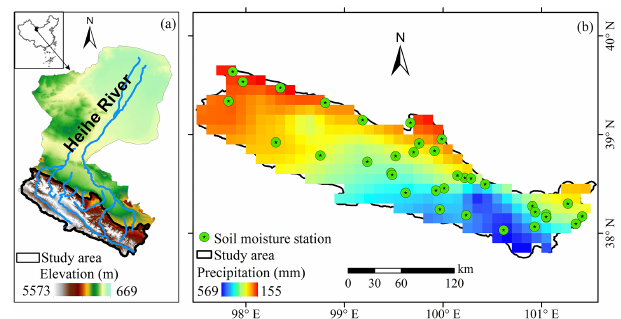
Figure 1. (a) Study area and (b) distribution of the SM stations with spatial distribution of annual average precipitation from 2014 to